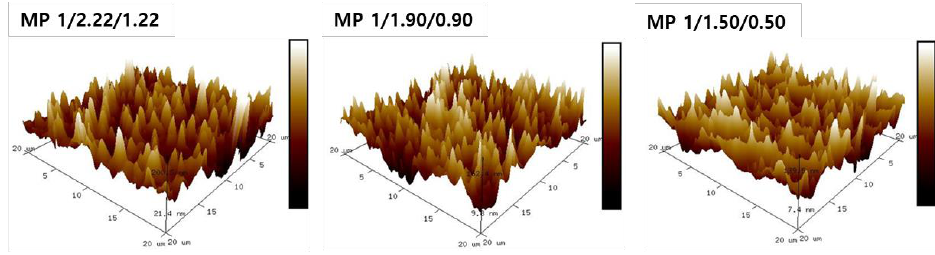
Figure 4. AFM phase images of the freeze-fractured surfaces of the prepared bio-based SMTPUs. Table 5. Surface characterization of the AFM phase images of the SMTPU films. Sample